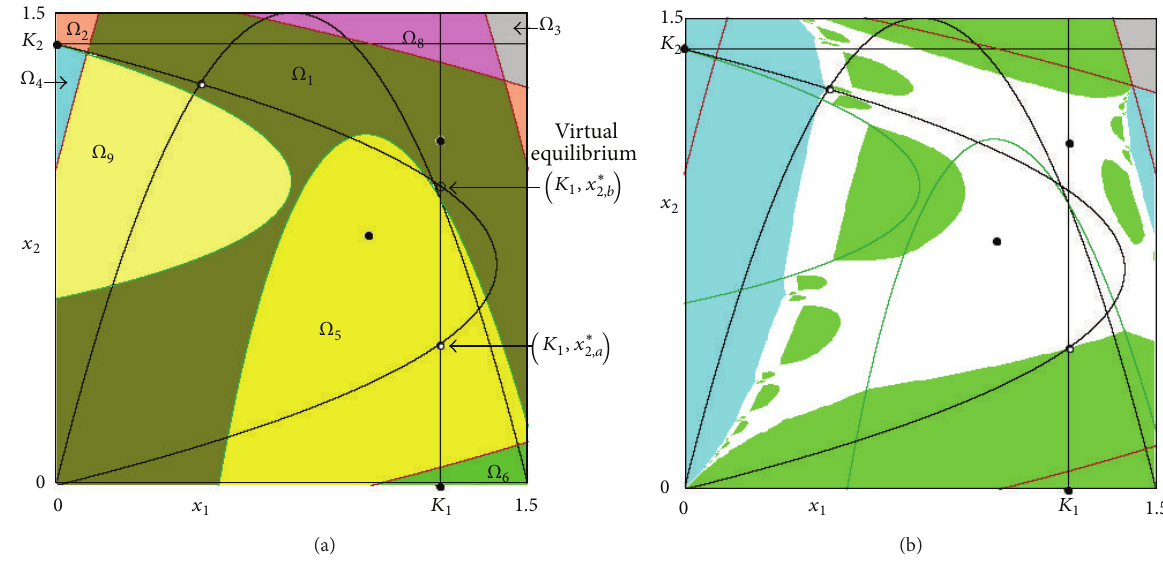
Figure 5: Parameters: 𝑁 1 = 1.5 , 𝑁 2 = 1.4 , 𝜏 1 = 𝜏 2 = 4 , 𝛾 1 = 𝛾 2 = 1 , 𝐾 1 = 1.22 , and 𝐾 2 = 1.4 . Panel (a), phase space divided in regions 𝑖 = 1, ...,9 . Panel (b), the green (resp., azure) region is the basin of attraction of the superstable equilibrium of segregation (𝐾 Ω 𝑖 , ) ), while the white region is the basin of attraction of the stable 2-cycle born through a nonsmooth saddle-node bifurcation. In these (0,𝐾 2 two Panels 𝐵𝐶 1,𝐾 and 𝐵𝐶 2,𝐾 are the dark-green curves and 𝐵𝐶 1,0 and 𝐵𝐶 2,0 the dark-red curves, while 𝜙 1 and 𝜙 2 are the black curves. The empty dot indicates the virtual equilibrium (𝐾 1 ,𝑥 ∗ 2,𝑏 ) .